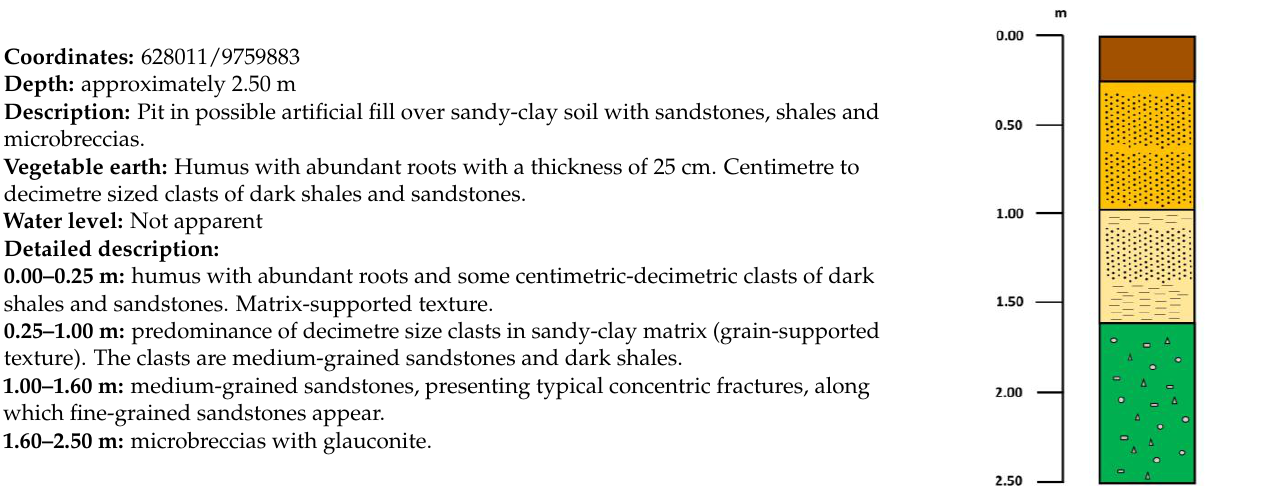
Table 10. Information of